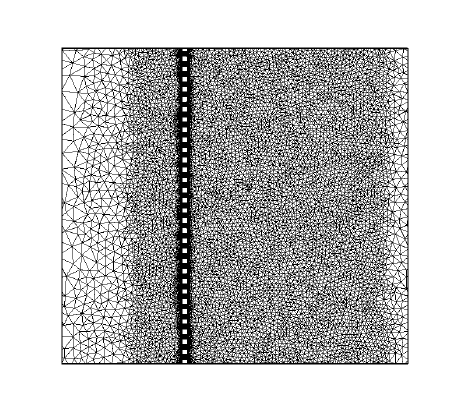
Fig. 1. Detail of the mesh around dense fence.